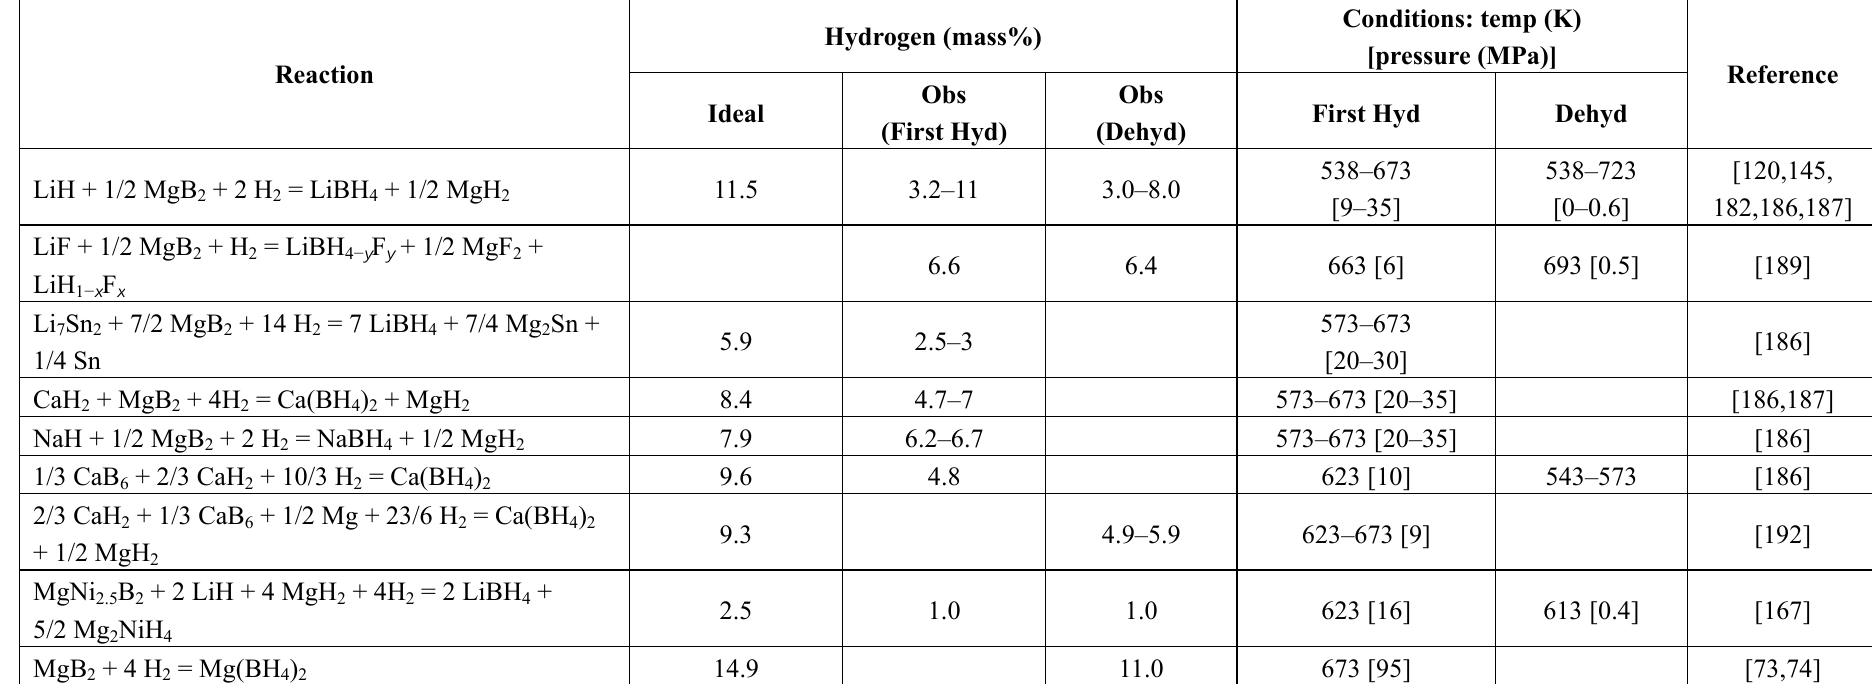
Table 4. Hydrogen storage properties of metal borides and metal hydrides